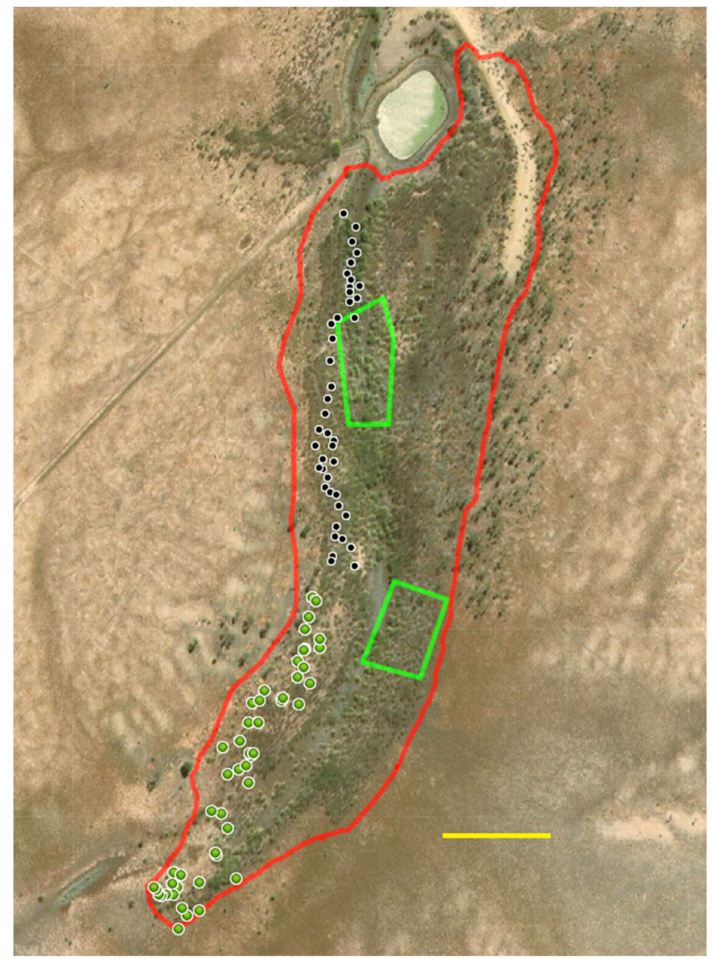
Figure 14. Outline (in red) of south infestation boundary as tracked by GPS (11.2 ha); green circle markers indicating waypoints at which magazines of 15 doses were initiated. Light green boundaries indicate reference (control) sectors. Black circle markers indicate assessment points for linear transect. Scale bar = 100 m. Background imagery [24] accessed April